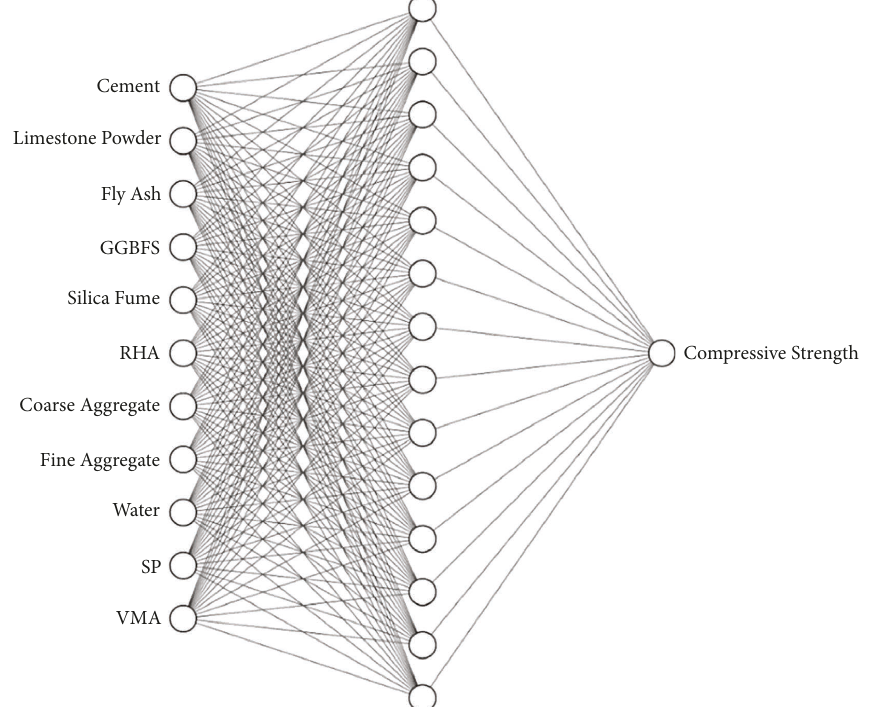
Figure 1: The optimal ANN identified in this study has 11 input nodes, 14 hidden layer nodes, and one output node in the output